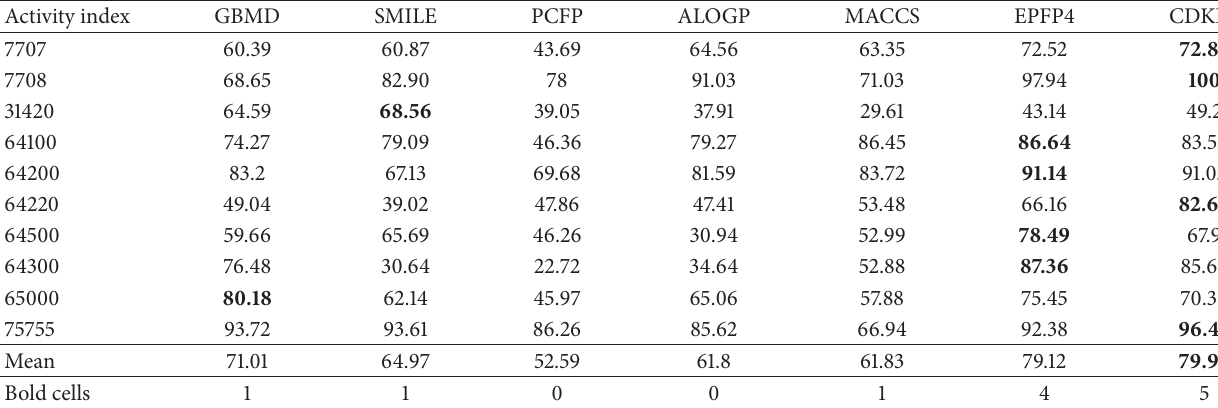
Table 6: Retrieval results of top 1% for data set